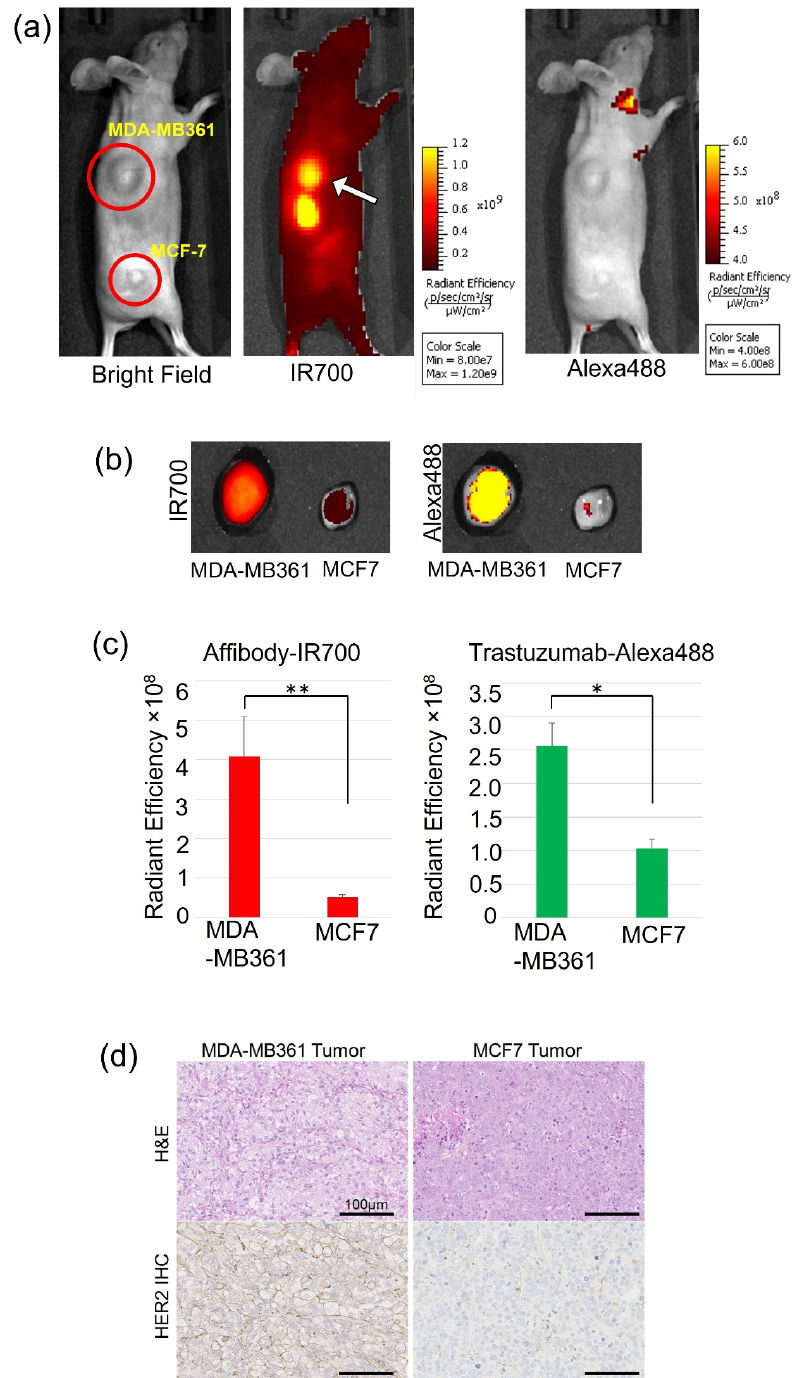
Figure 7. ( a ) In vivo imaging of tumor xenograft-bearing mice with HER2 Affibody-IR700Dye conjugate and trastuzumab-Alexa488 conjugate. The image shows high-intensity IR700Dye fluorescence in the MDA-MB361 tumor (shoulder, white arrow) in contrast to the MCF7 tumor (right dorsum). ( b ) The excised MDA-MB361 tumor exhibited higher fluorescence intensity of HER2 Affibody-IR700Dye conjugate and trastuzumab-Alexa488 conjugate in contrast to the MCF7 tumor. ( c ) The fluorescence intensities of IR700Dye and Alexa488 showed a significant difference ( n = 3, * p < 0.05; ** p < 0.01, Student’s t -test). Data are presented as means ± SD. ( d ) The immunohistochem- istry of HER2 protein from the engrafted tumors revealed stronger positive HER2 staining on the cell membrane of the MDA-MB361 tumor than on the MCF7